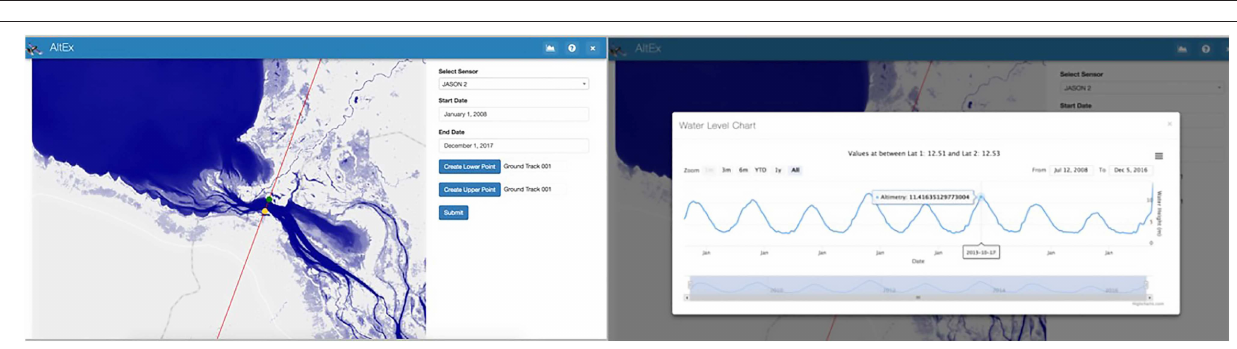
as part of an AST project and is used to support national ministries in East and Southern Africa in monitoring